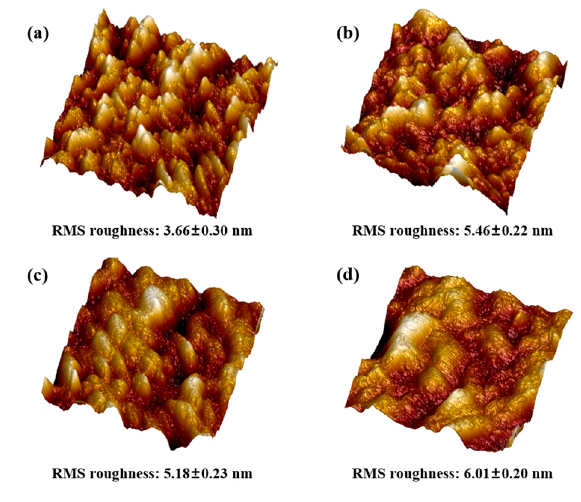
Figure 7. Atomic force microscopy (1 × 1 μ m) and roughness (RMS) of TiN coatings under different substrate temperatures: ( a ) Ts35; ( b ) Ts200; ( c ) Ts400; ( d ) Ts600. substrate temperatures: ( a ) Ts35; ( b ) Ts200; ( c ) Ts400; ( d ) Ts600.